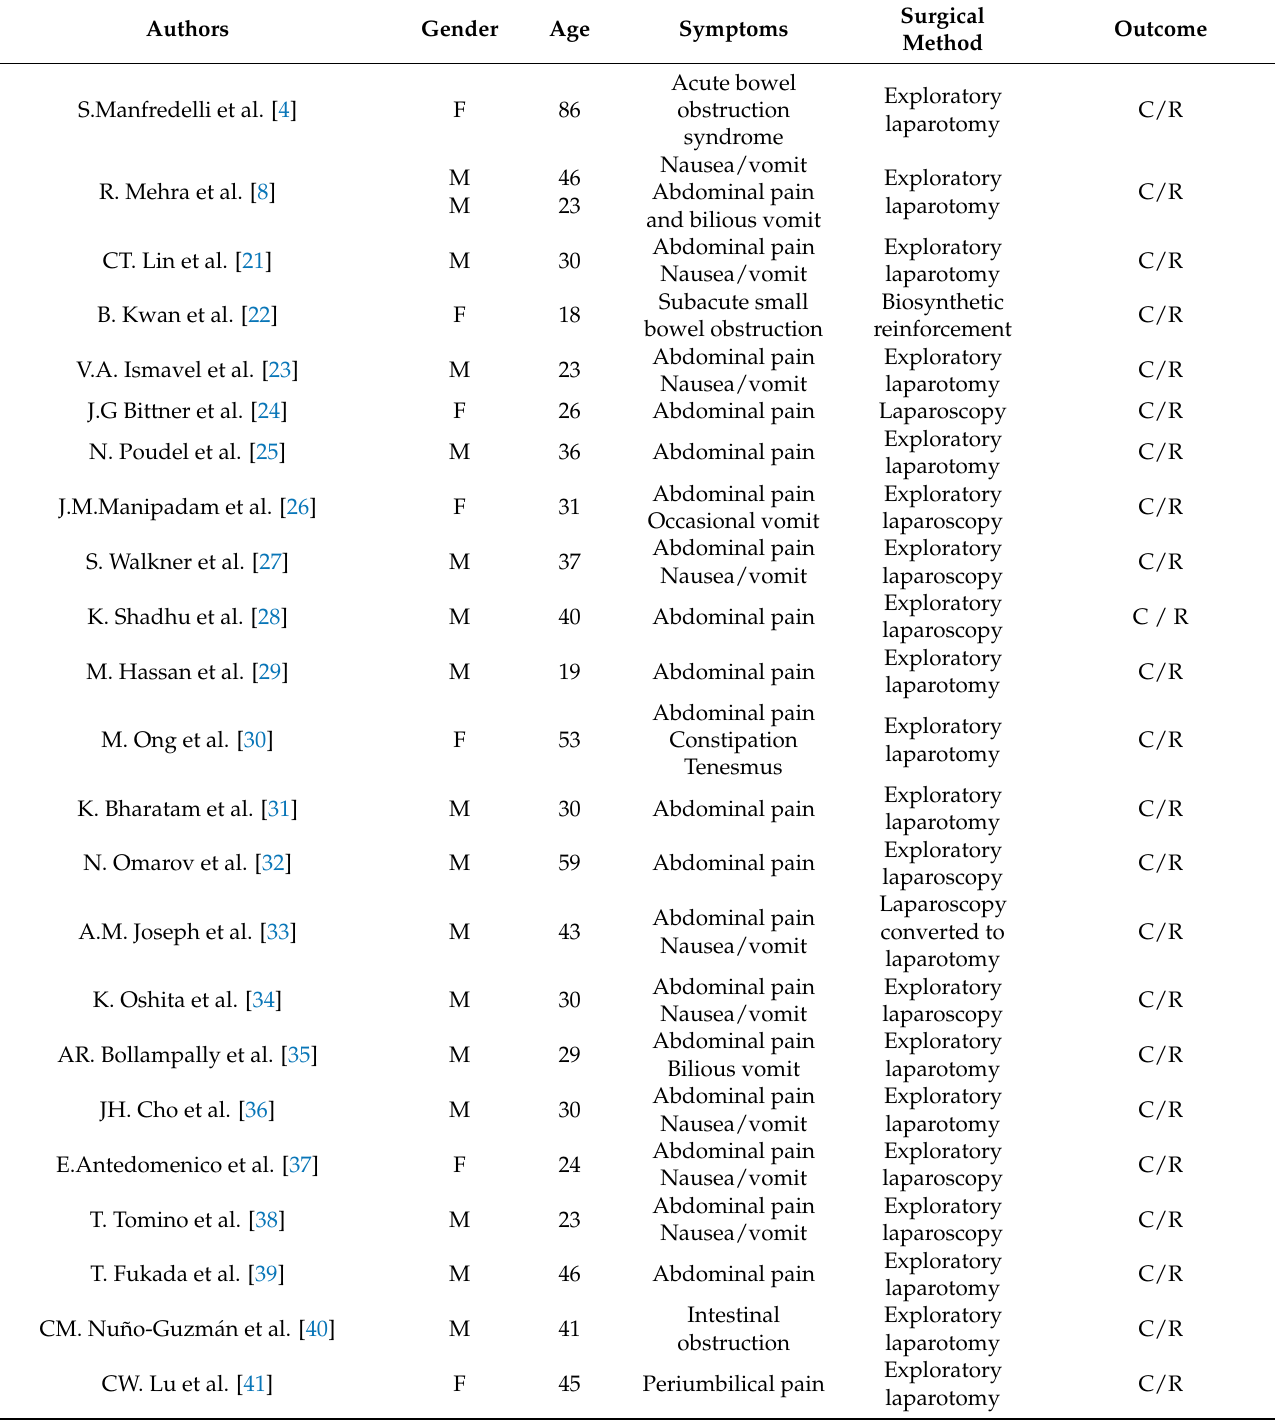
(Table 1). The vast majority of patients present with diffuse abdominal pain accompanied by vomiting or nausea or signs of acute small bowel obstruction. In all cases, an investigation surgery, open or laparoscopic, was conducted. The overall outcome was complete recovery of the patient. Table 1. Previously reported cases of right